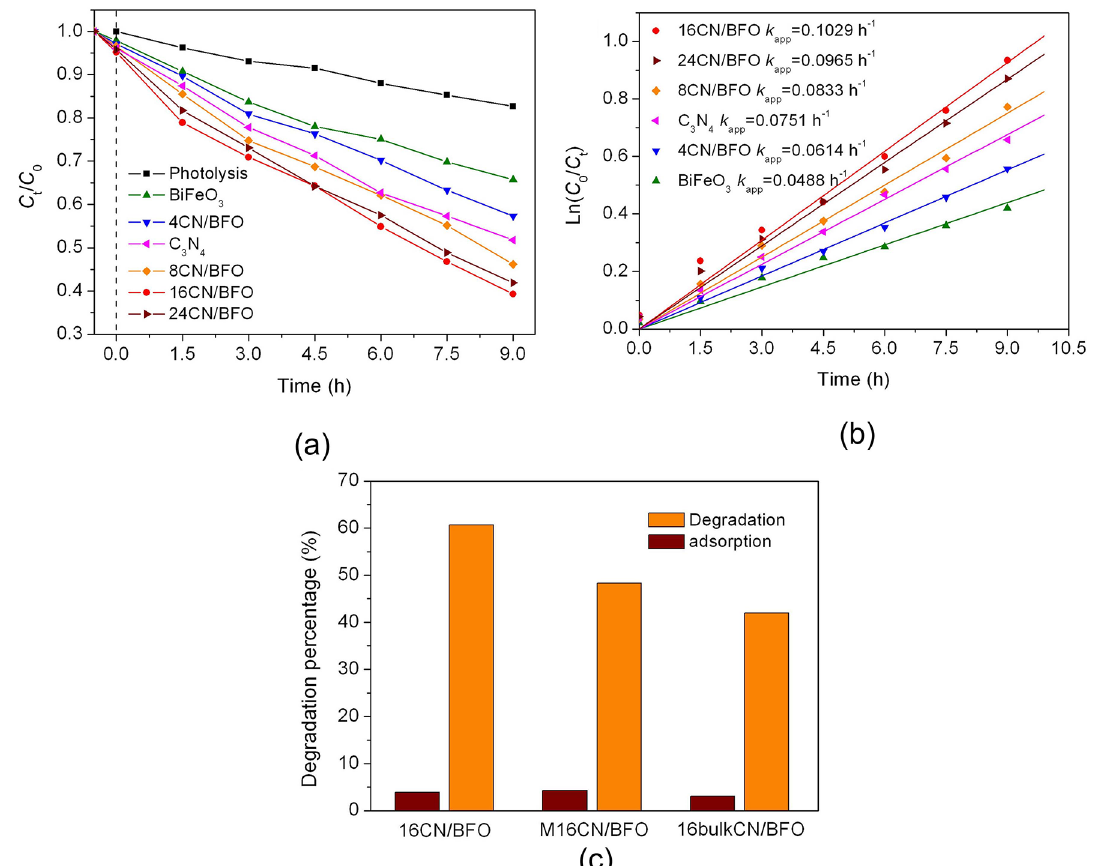
N nanoparticles, 3 4 N nanoparticles, BiFeO and 3 4 3